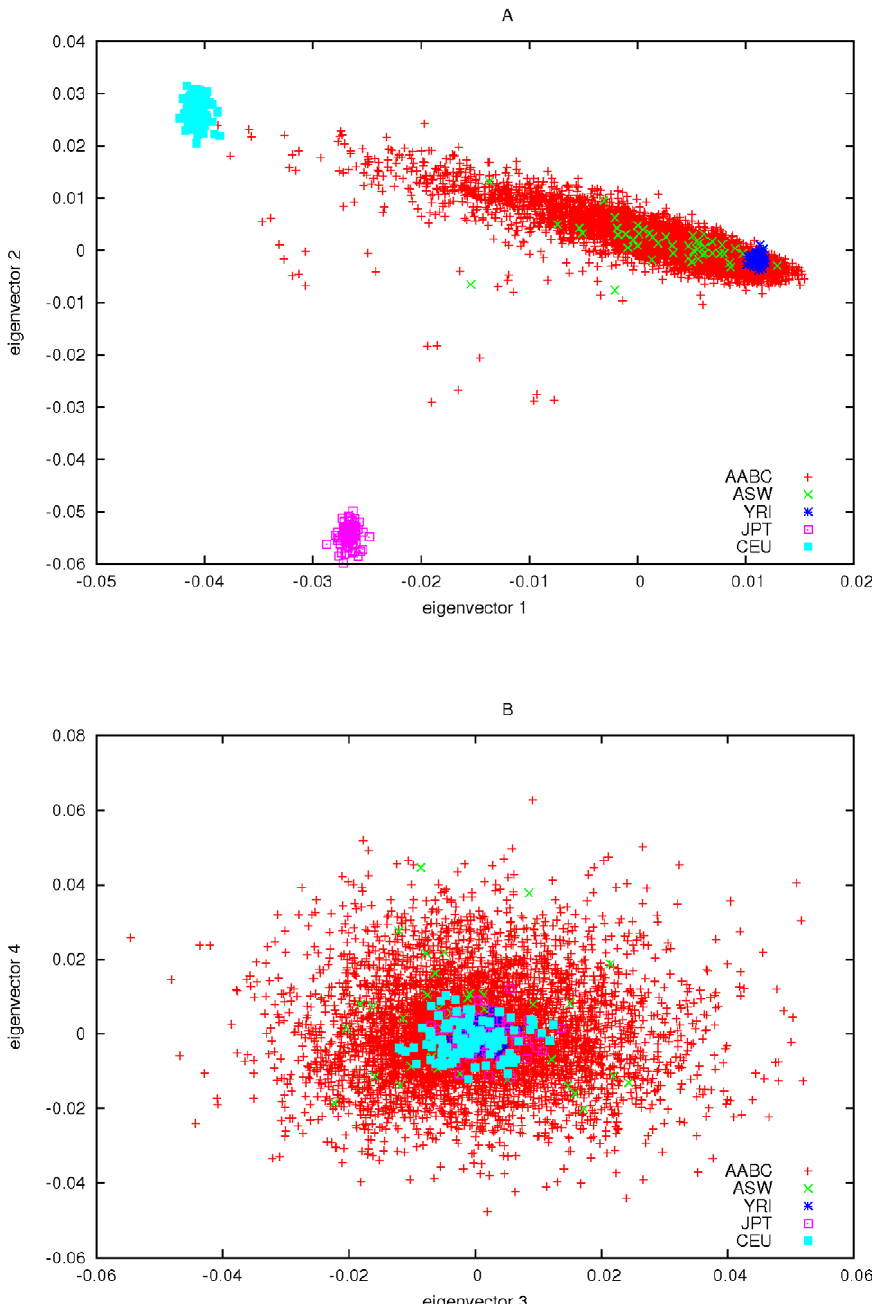
Figure 3. Principal components plots of AABC and selected HapMap samples.